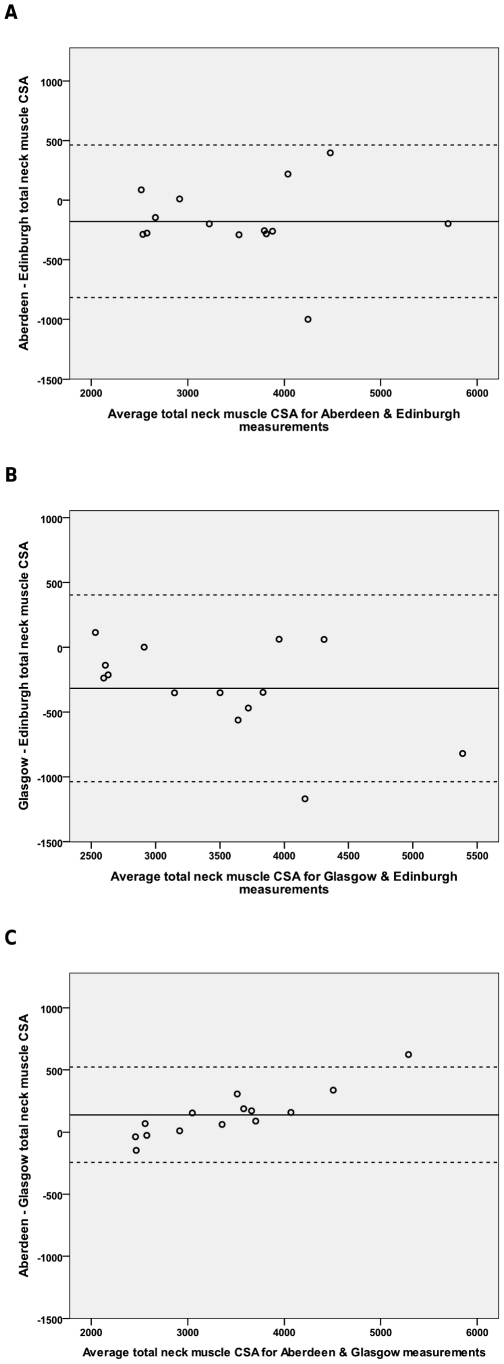
Bland-Altman plots for total neck muscle CSA measured on 3 different MRI scanners.Bias of measurement between different MRI scanners (mean of the ordinate) and limits of agreement (2sd) are represented by a solid and two dashed lines respectively. A. Bland-Altman plot for total neck muscle CSA measured on the Aberdeen and Edinburgh MR images. B. Bland-Altman plot for total neck muscle CSA measured on the Edinburgh and Glasgow MR images. C. Bland-Altman plot for total neck muscle CSA measured on the Glasgow and Aberdeen MR images.